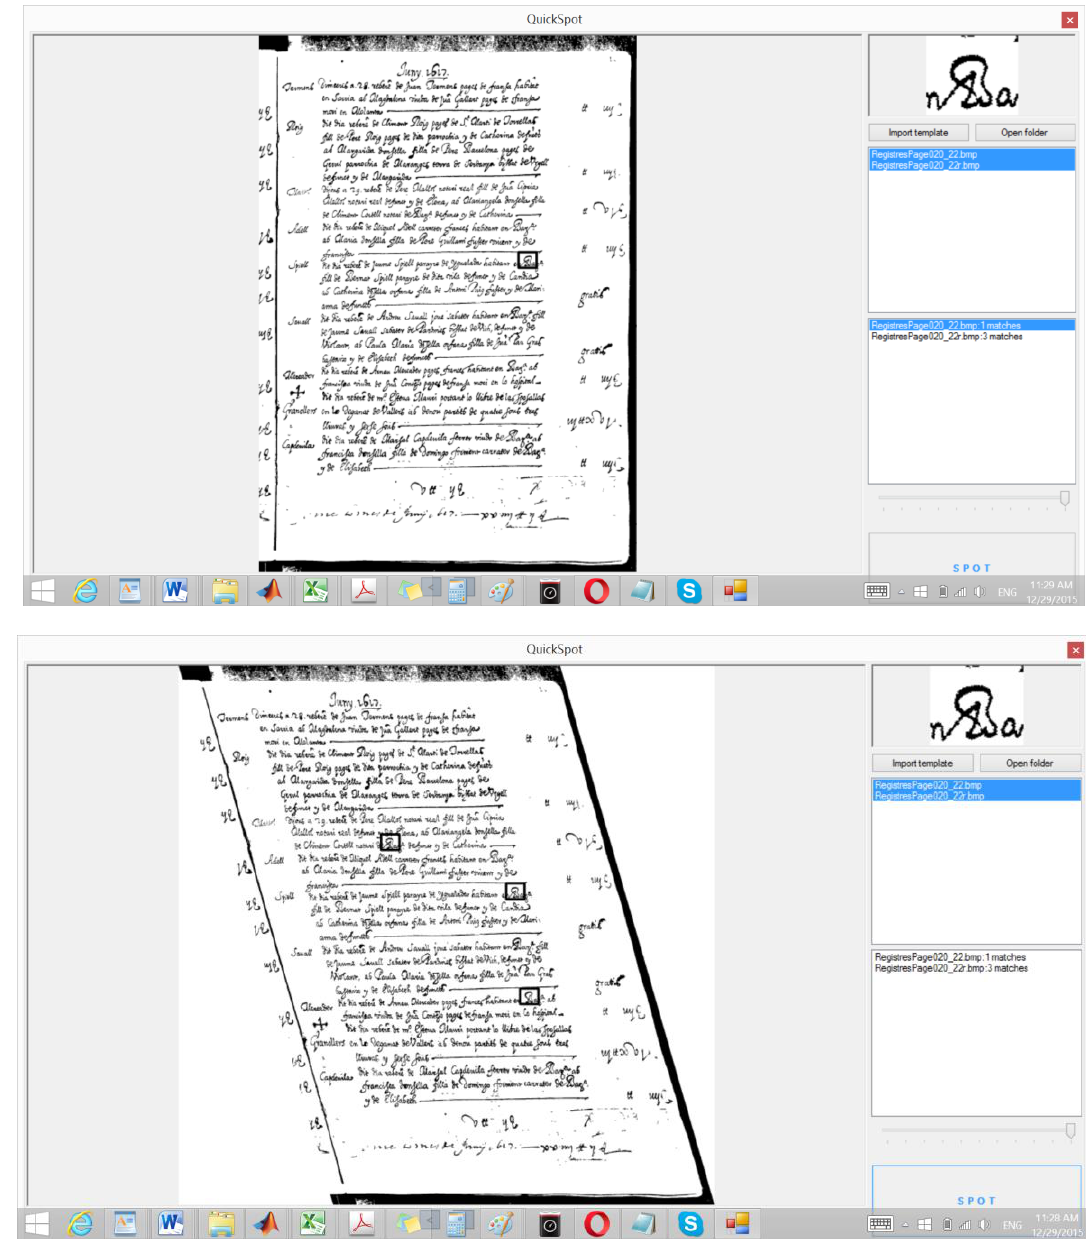
Figure 14. Application of the word-spotting system [25], before ( above ) and after ( below ) slant